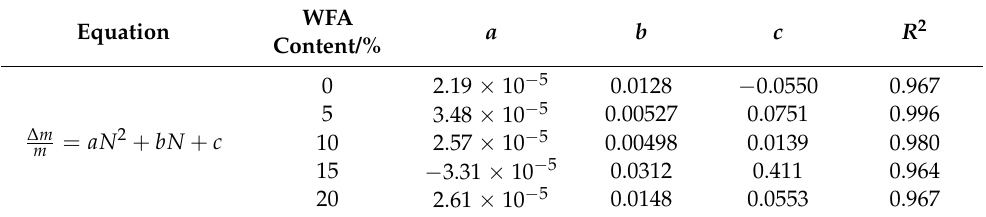
( b ) Figure 6. Relationship between the mechanical strength loss rates of RPC with WFA and NaCl freeze–thaw cycles: ( a ) flexural strength ( f t ) loss rate; ( b ) compressive strength ( f cu ) loss rate.